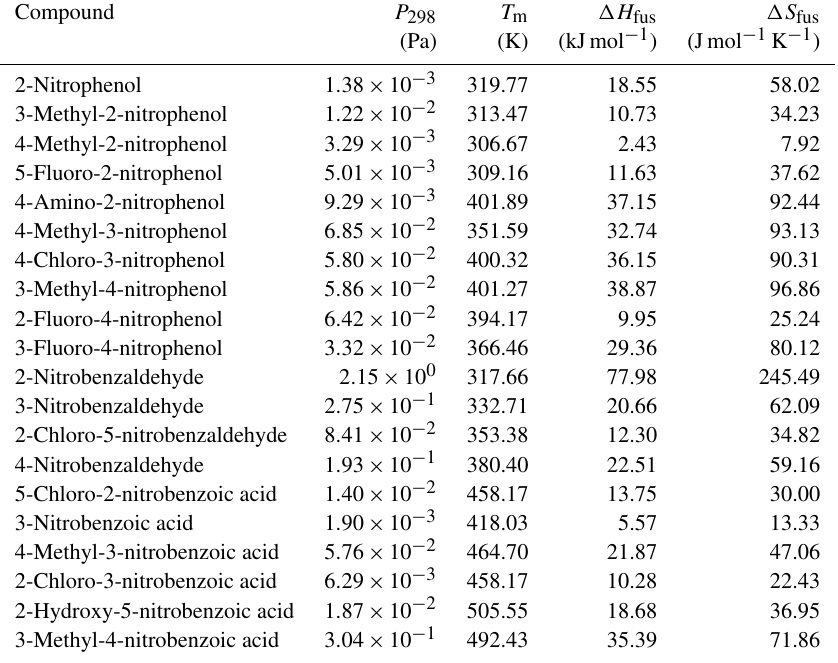
Table 7. P sat , melting point, and the enthalpy and entropy of fusion of the L